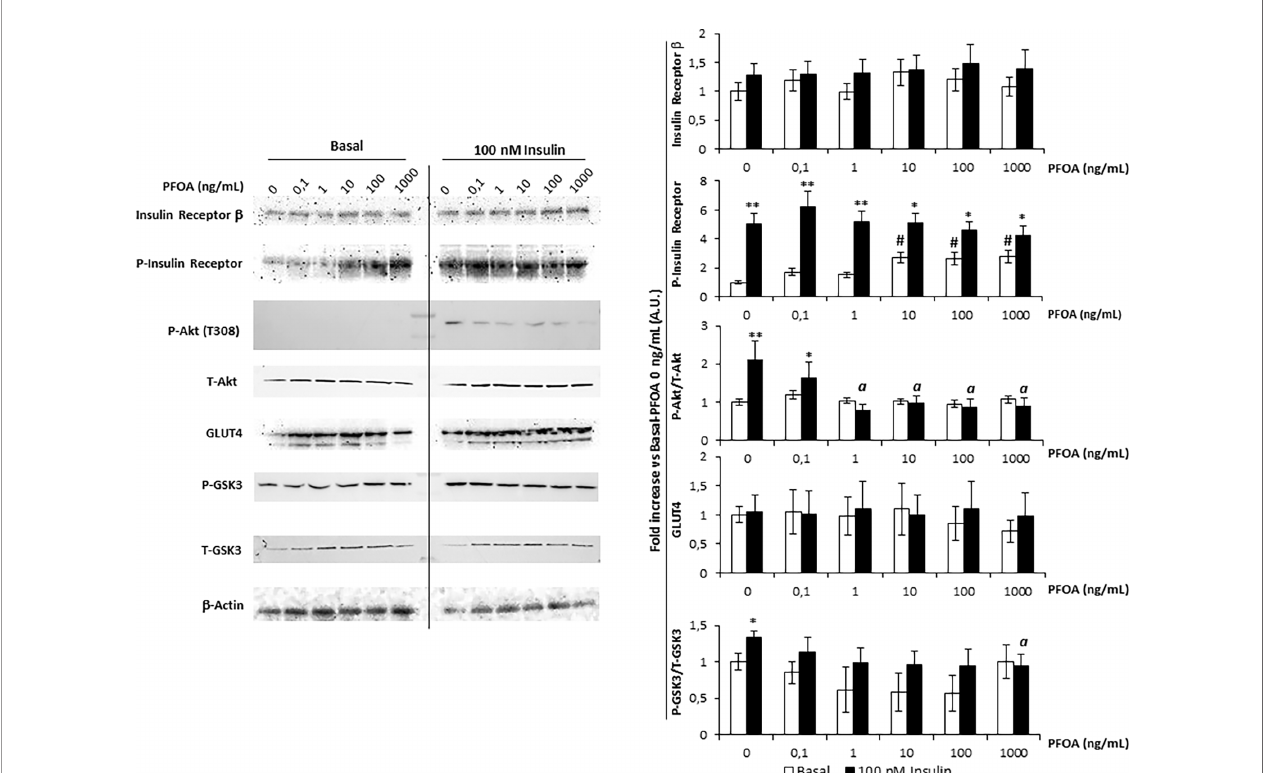
FIGURE 2 | Western blot analysis of Insulin Receptor signaling pathway in HepG2 cells, in basal condition and stimulated with 100 nm Insulin, after the exposure for 24 with per fl uoro-octanoic acid (PFOA) at increasing concentration. b -Actin served as housekeeping. The histogram plot in shows the corresponding results of band density analysis. Data were normalized on the corresponding b -Actin and reported as the fold increase compared to control condition, in which both PFOA and Ins were omitted, representing the mean value of three independent experiments. Signi fi cance: *P < 0,05 and **P < 0,01 respectively vs corresponding basal where Ins was omitted. a P < 0,05 vs control + 100 nm Ins. # P < 0,05 vs control condition in which both PFOA and Ins were